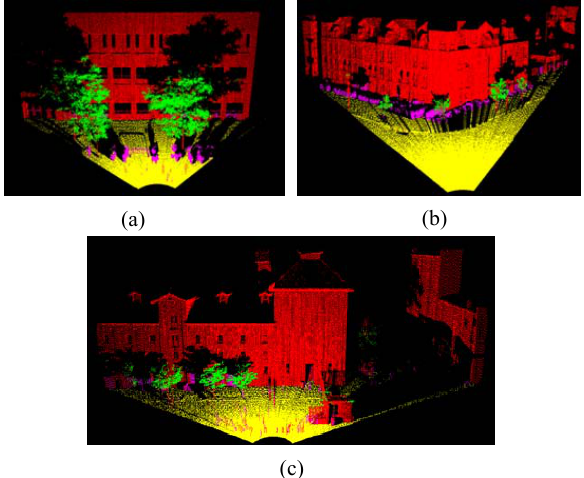
Figure 3.Visulization of classification by CRF. (a) Seneca building, York University, (b) Passy residence,York University, (c) Building at Distillery district, Toronto. Red: Vertical objects; Blue: Ground; Green: Tree; Purple: Low object.